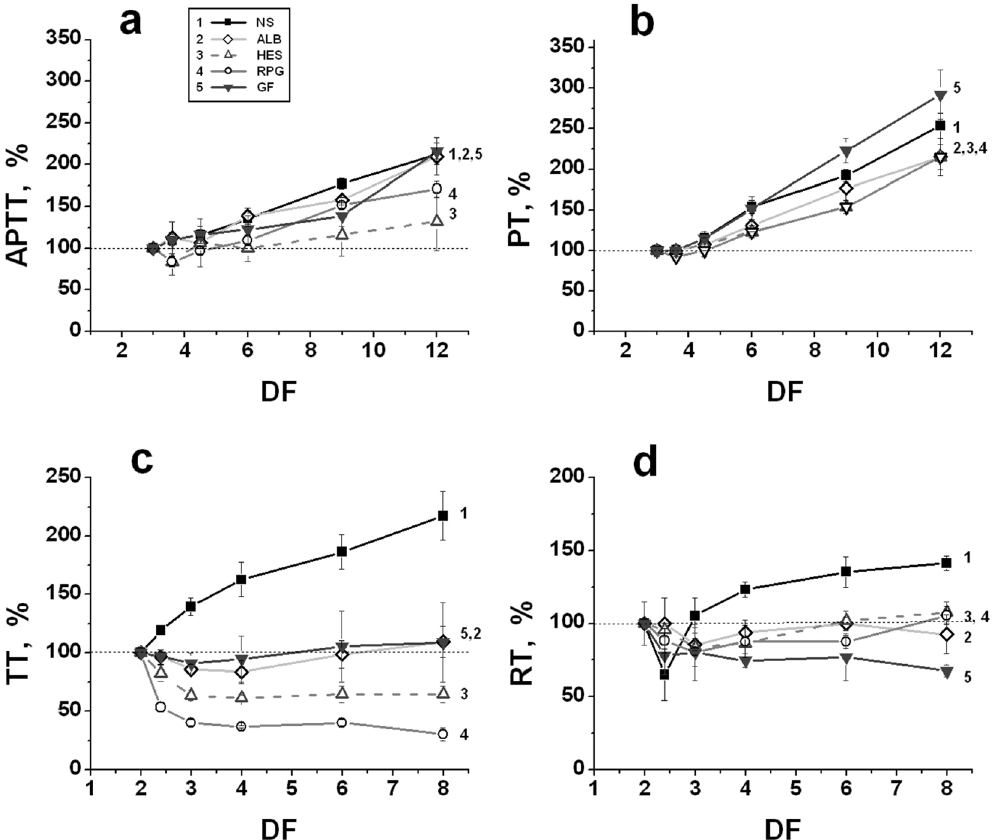
Figure 1. Standard clotting times of plasma diluted with various PEs in vitro . ( a ) – Activated partial thromboplastin time (APTT); ( b ) – prothrombin time (PT); ( c ) – thrombin time (TT); and ( d ) – recalcification time (RT). The following PEs were used for dilution: (1) – normal saline (NS); (2) – 10% solution of human albumin (ALB); (3) – 6% solution of hydroxyethyl starch 130/0.4 (Voluven, HES); (4) – 10% solution of dextran 40 (Reopolyglukin, RPG); (5) – 4% solution of succinylated gelatin (Gelofusine, GF). The value of each parameter in plasma without dilution was taken as 100%. The mean values ± standard deviation (SD) are presented (n = 6). DF (a dilution factor) characterizes the value of dilution and is equal to the ratio of the